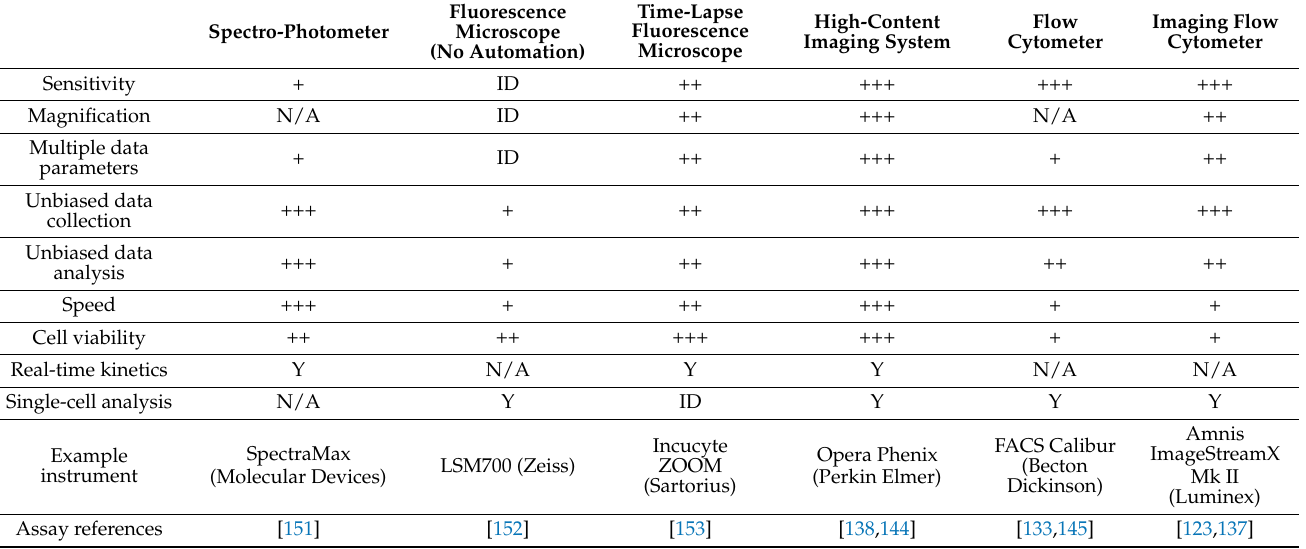
Table 3. Comparing types of instrument used to measure phagocytosis. +: low; ++: medium, +++: high; ID: Instrument-dependent; N/A: not applicable; Y: